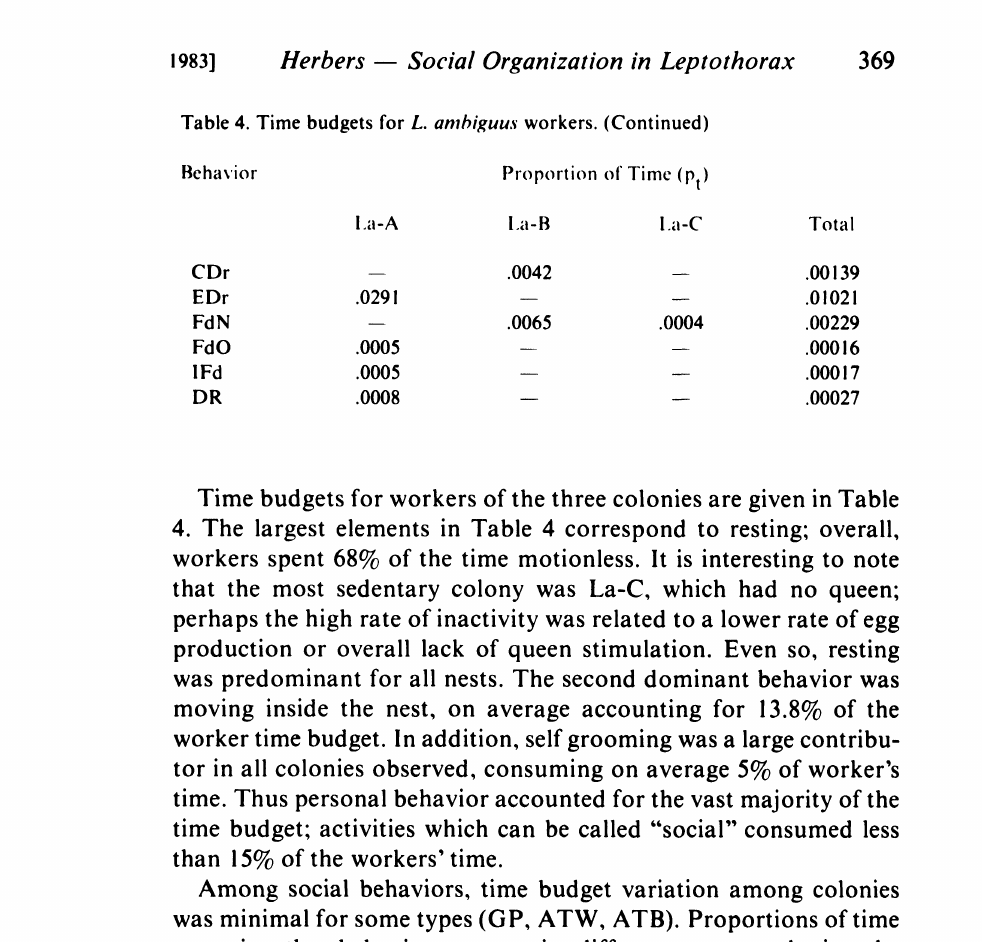
Table 4. Time budgets for L. amhiguus workers.